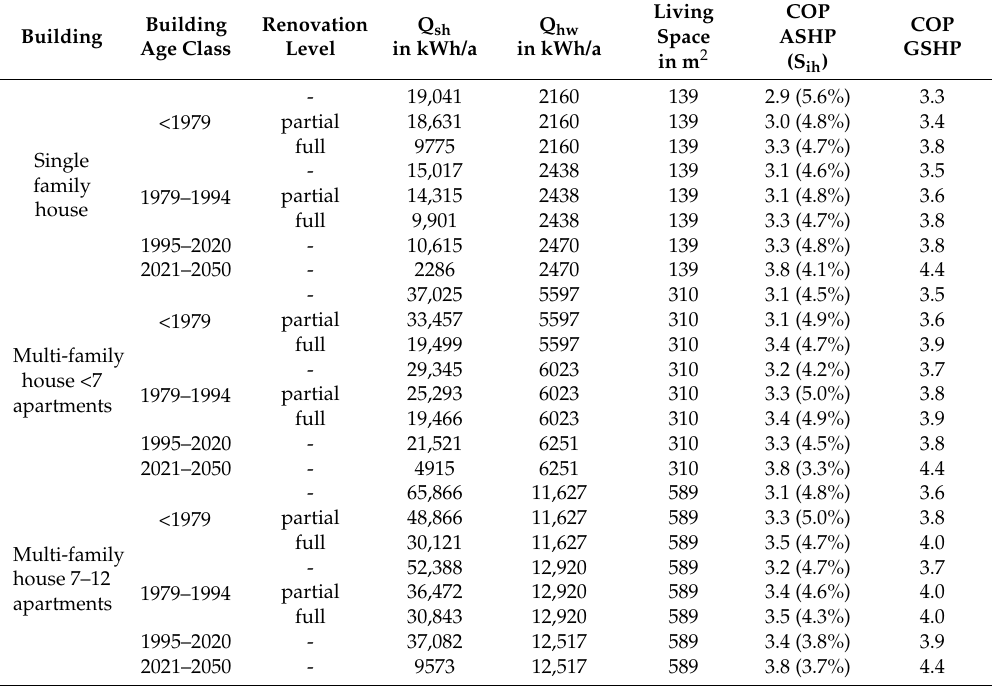
Table A1. Analysed COPs of the simulated building categories and their characteristic